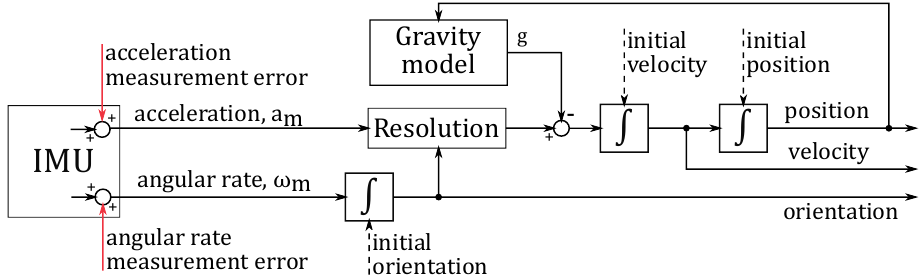
Figure 1. Block diagram of basic strapdown inertial navigation system (INS).